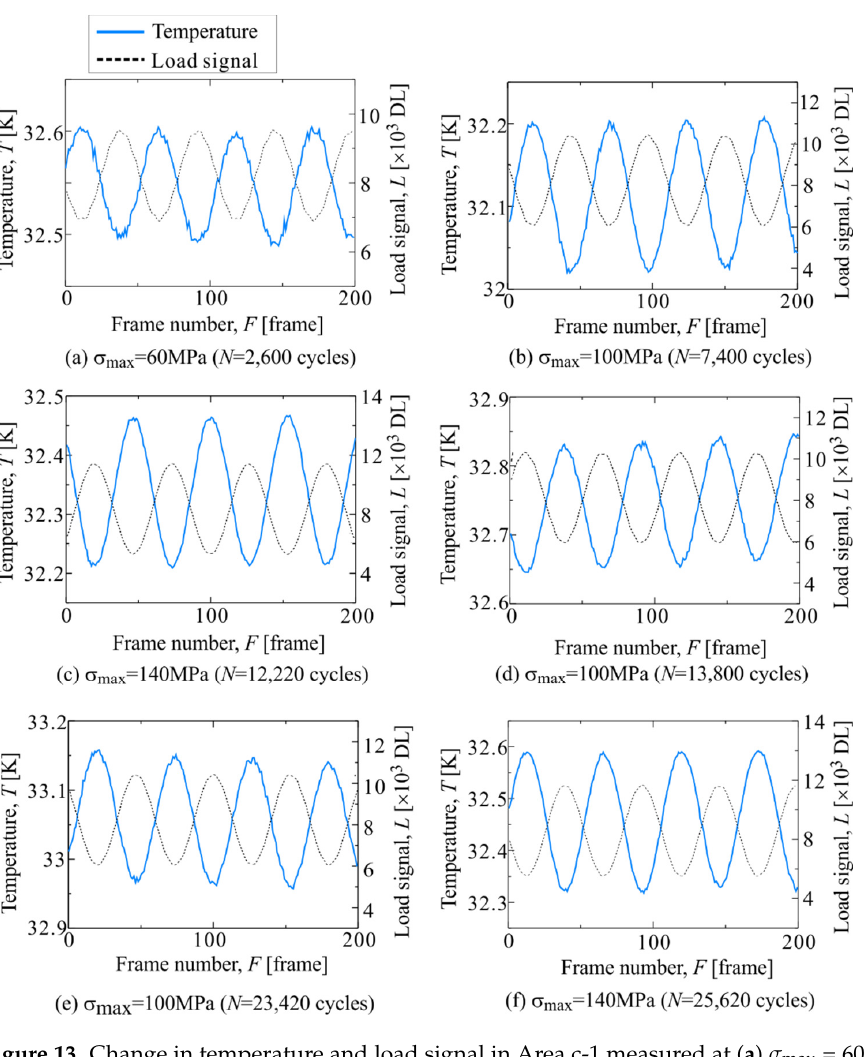
Figure 13. Change in temperature and load signal in Area c-1 measured at ( a ) σ max = 60 MPa and N = 2600 cycles, ( b ) σ max = 100 MPa and N = 7400 cycles, ( c ) σ max = 140 MPa and N = 11,200 cycles, ( d ) σ max = 100 MPa and N = 13,800 cycles, ( e ) σ max = 100 MPa and N = 23,420 cycles and ( f ) σ max = 140 MPa and N = 25,620 cycles.